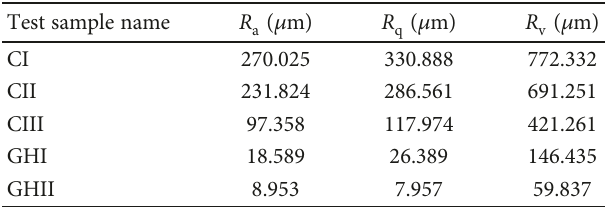
Table 4: Local roughness of test